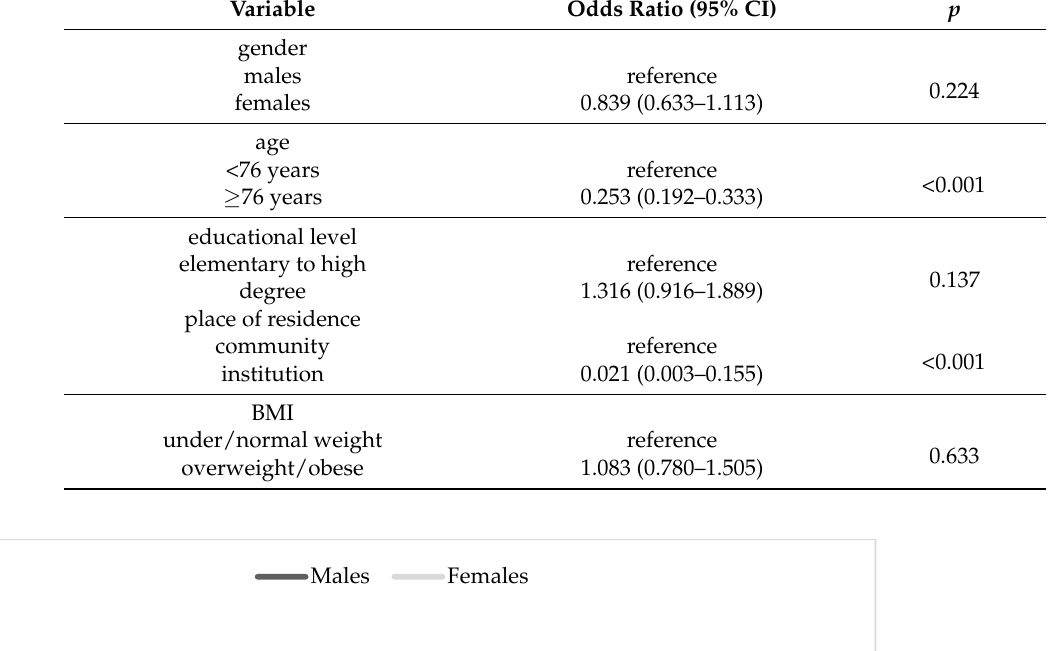
Table 4. Logistic regression model built on PASE scores as outcomes.